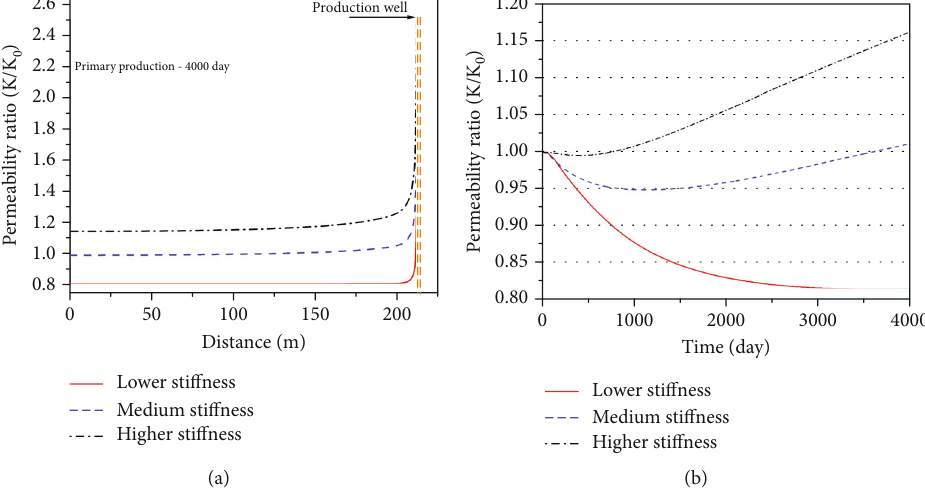
Figure 12: Permeability evolution within CBM reservoir during primary production. (a) Evolution of permeability ratio along reference section A-B. (b) Evolution of permeability ratio at reference point